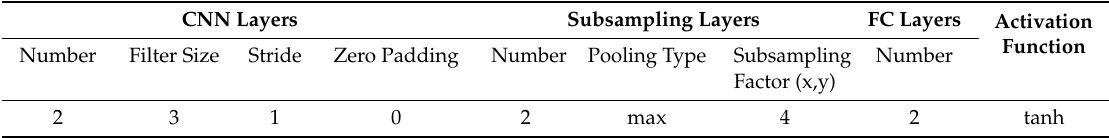
Table 1. CNN hyperparameters.